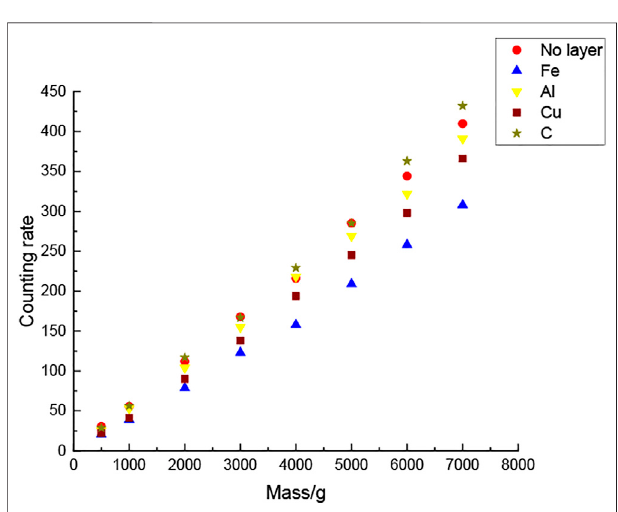
FIGURE 9 | Total counting rate of different packaging